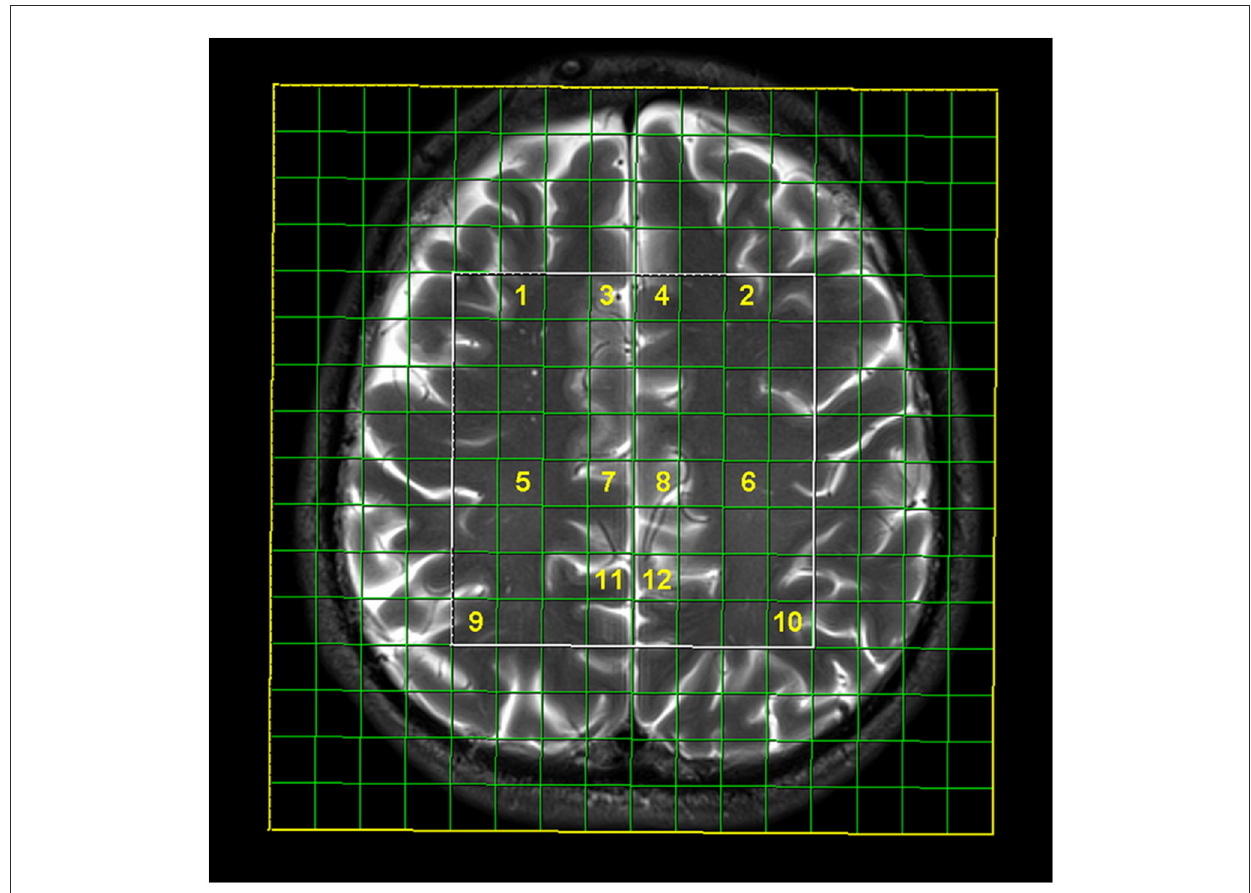
FIGURE1 Multi-voxel magnetic resonance spectroscopy network with selected localizations: frontal subcortical white matter on the right (1) and left (2), anterior cingulate gyrus on the right (3, 7) and left (4, 8), posterior cingulate on the right (11) and left (12), frontal deep white matter on the right (5) and left (6), and parietal subcortical white matter on the right (9) and left (10).